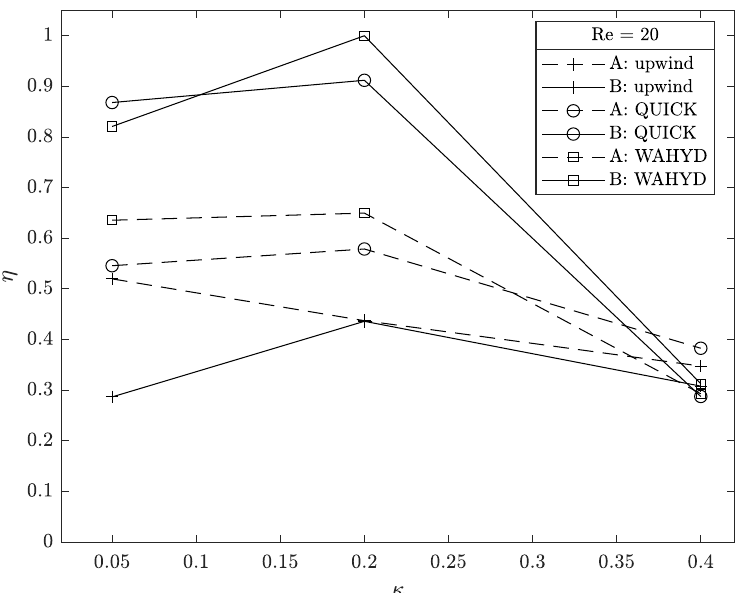
Figure 34. Computational efficiency as function of κ for the flow around a cylinder case with Re = 20 using the E